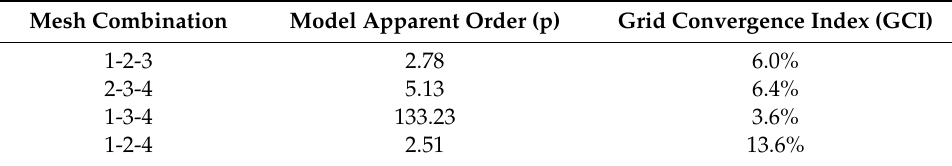
Table 2. Results of the mesh convergence